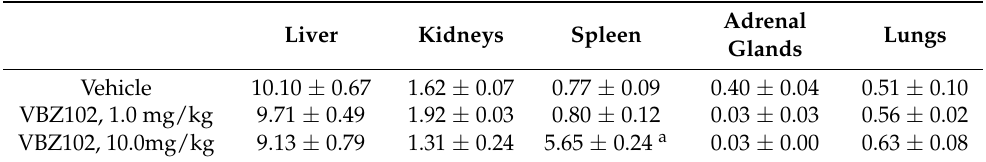
Table 2. Effect of the orally administered VBZ102 on average relative organ weight (%) at the 28th day of treatment.